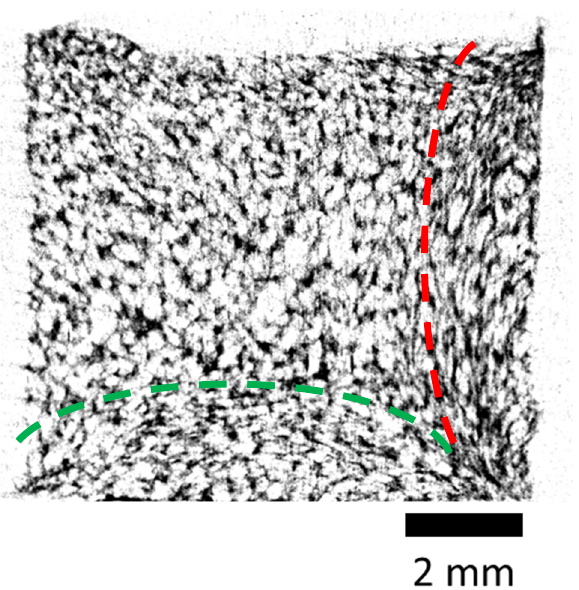
Figure 6. Orthogonal tomographic cross-sections of the pores in the spherical approximation. Each pore is colored in a unique color.